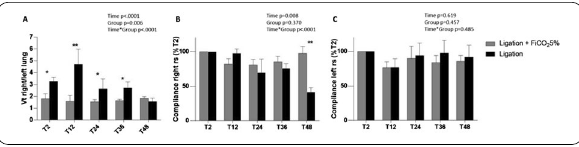
Fig. 1. Data were analyzed with generalized estimating equation mod- els. Vt Tidal Volume; rs respiratory system = = Conclusion. Redistribution of Vt to the perfused lung may be implied in the development of regional lung injury following ligation of con- tralateral pulmonary artery. Mechanisms inducing injury in the non- perfused lung remain to be elucidated. Reference(s)